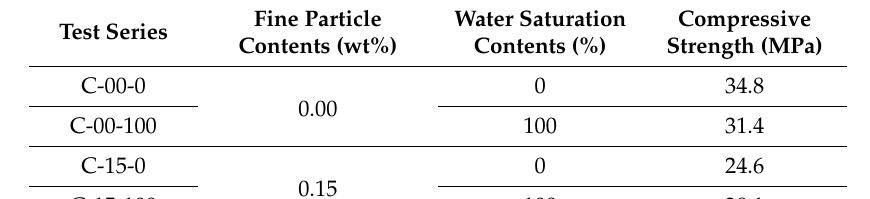
Table 4. Compressive strength of quick-converting track concrete.